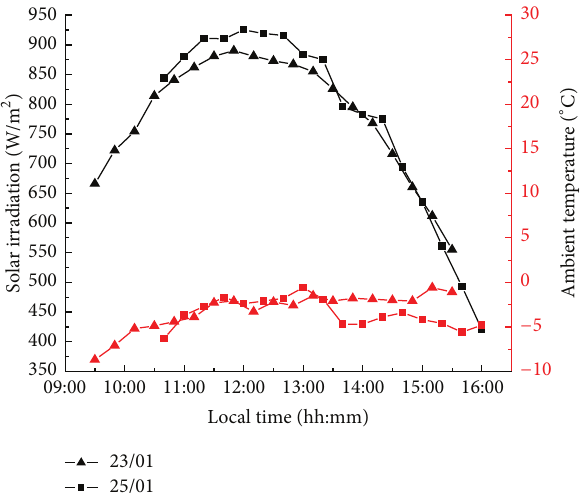
Figure 9: Change of the solar irradiance and ambient temperature with local time.